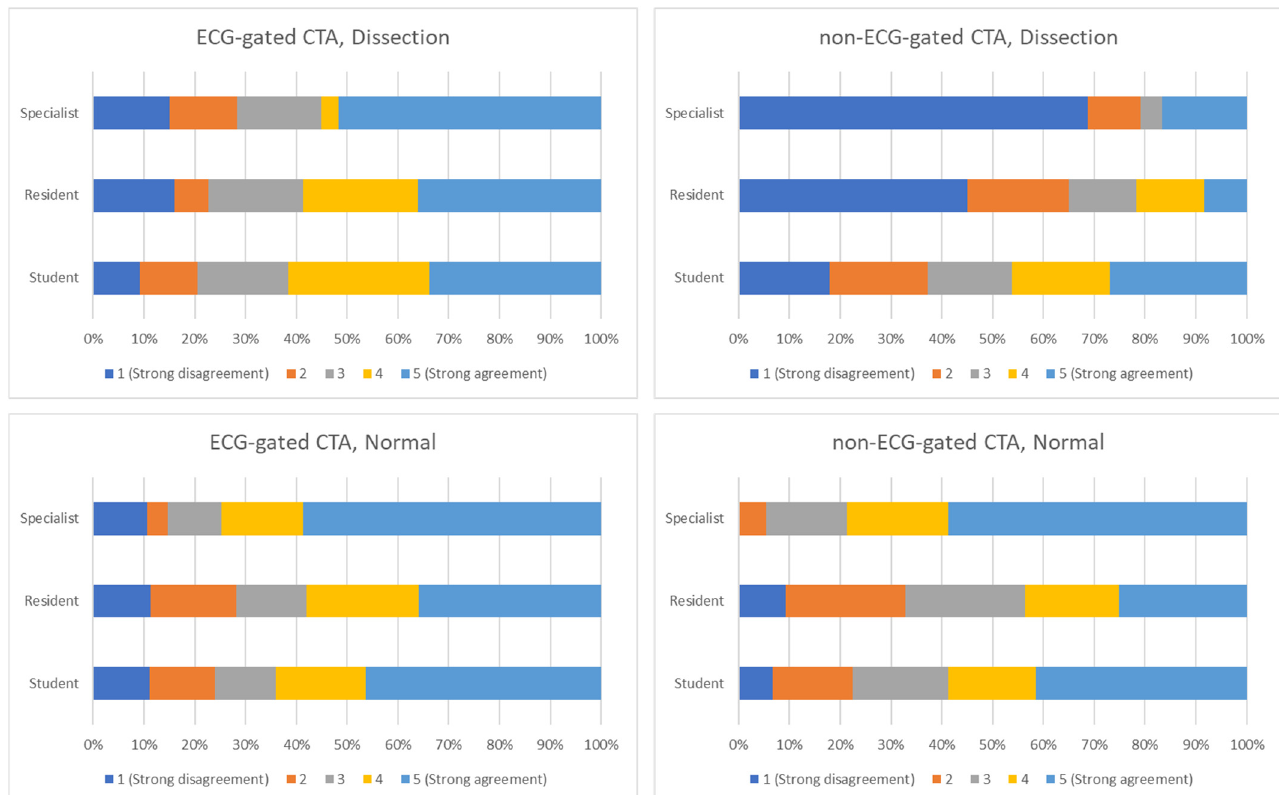
Figure 3. Agreement between different observers and type of image as answering the question “This is the CT of a patient with ascending aortic dissection”. ( Upper-left panel ): CTA performed using ECG gating, with positive dissection diagnosis. ( Upper-right panel ): CTA performed using without ECG gating, positive dissection diagnosis. ( Lower-left panel ): CTA performed using ECG gating, normal study. ( Lower-right panel ): CTA performed without ECG gating, normal study.